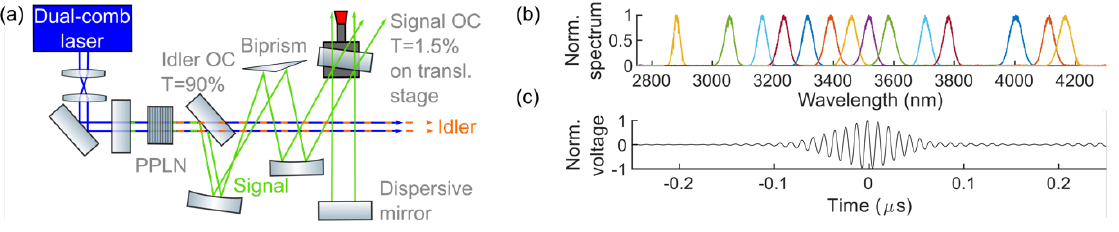
Fig. 1. (a) Schematic of the linear OPO cavity. Note, that for clarity the two combs are shown horizontally separated. In the laboratory, they are vertically multiplexed. (b) Tunable optical spectra of the idler